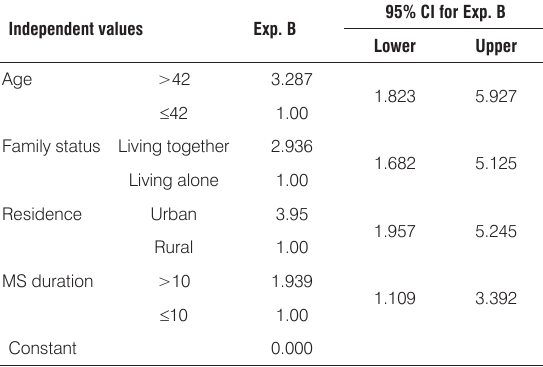
Table 5. Relation between social activity and socio-demographic and clinical factors.